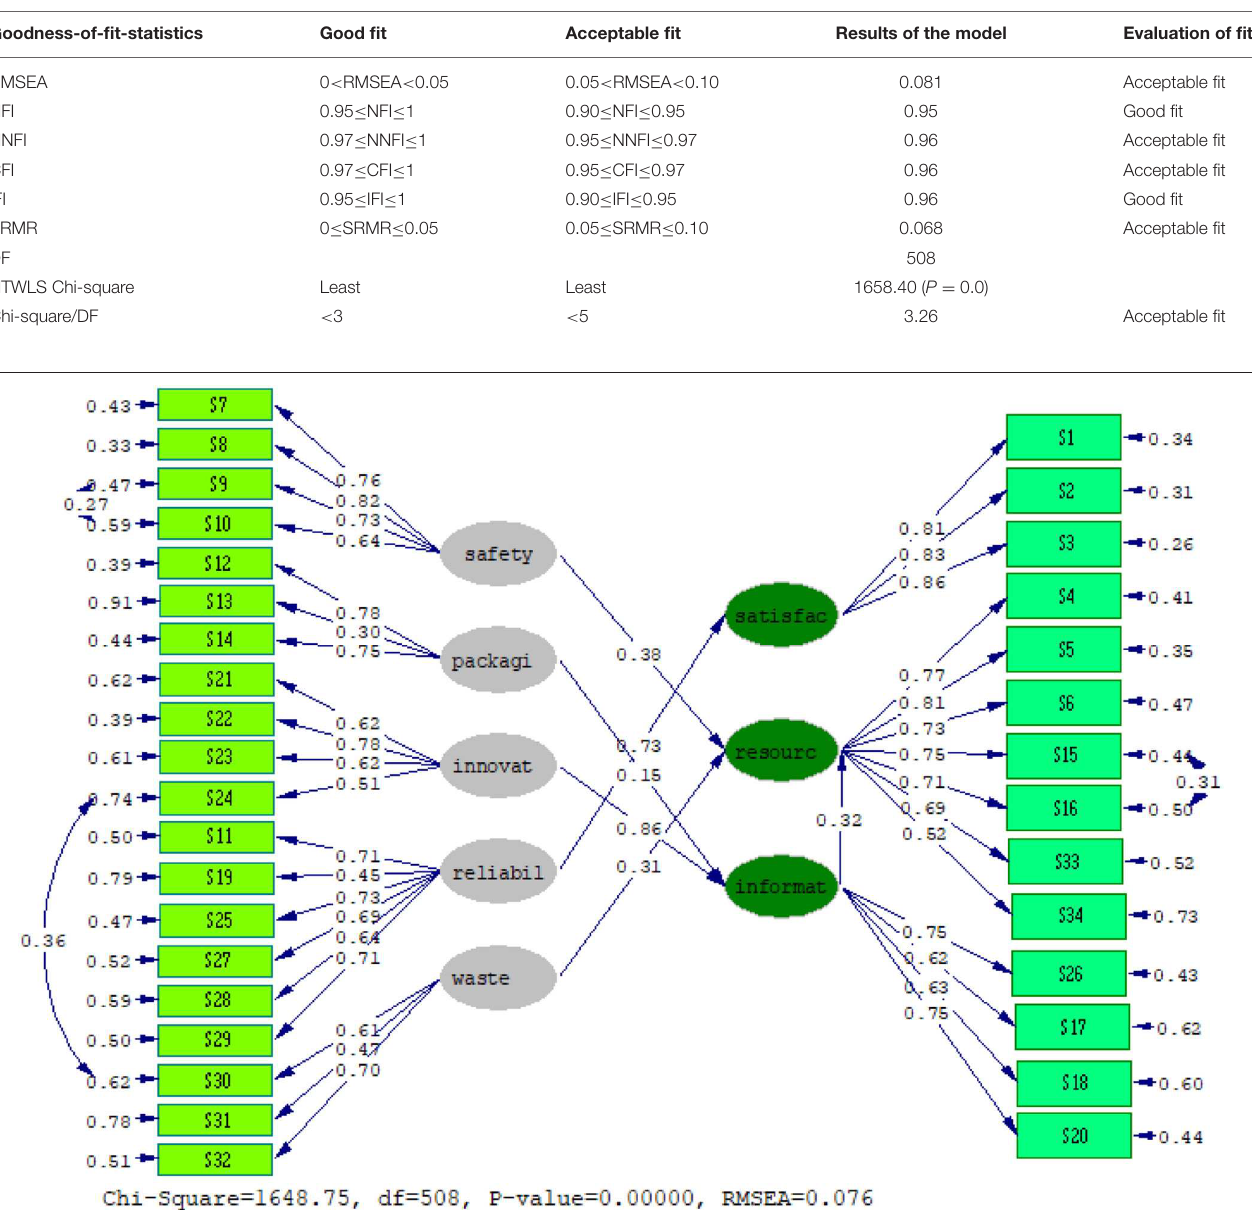
TABLE 4 | Compliance statistics for CFA model result.